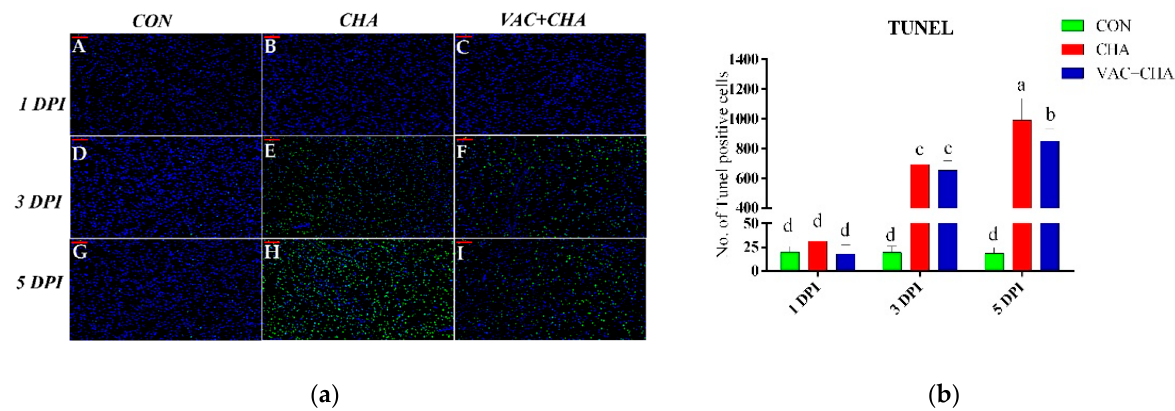
Figure 3. ( a ) T Fluorescent micrographs of chicken pancreas infected with NDV and stained by TUNEL assay technique. Panels ( A , D , G ) represent the control (CON) group at 1-, 3- and 5-days post infection (DPI). Panels ( B , E , H ) represent the NDV-challenged (CHA) SPF chickens. Panel ( C , F , I ) represent the vaccinated and NDV (VAC + CHA) challenge birds. Apoptotic cells show green nuclei, whereas the nuclei in the normal cells are shown in blue color. ( b ) The graphical representation of TUNEL positive cells in different groups. The green, red, and blue columns represent control, nonvaccinated challenged, and vaccinated challenged groups, respectively. The bars represent the standard deviation of the mean and lower-case letters show statistical significance ( p < 0.05) among different groups. CON, control; CHA, Newcastle disease virus challenged; VAC + CHA, vaccinated with LaSota and challenged with virulent Newcastle diseases virus after 2 weeks of vaccination.